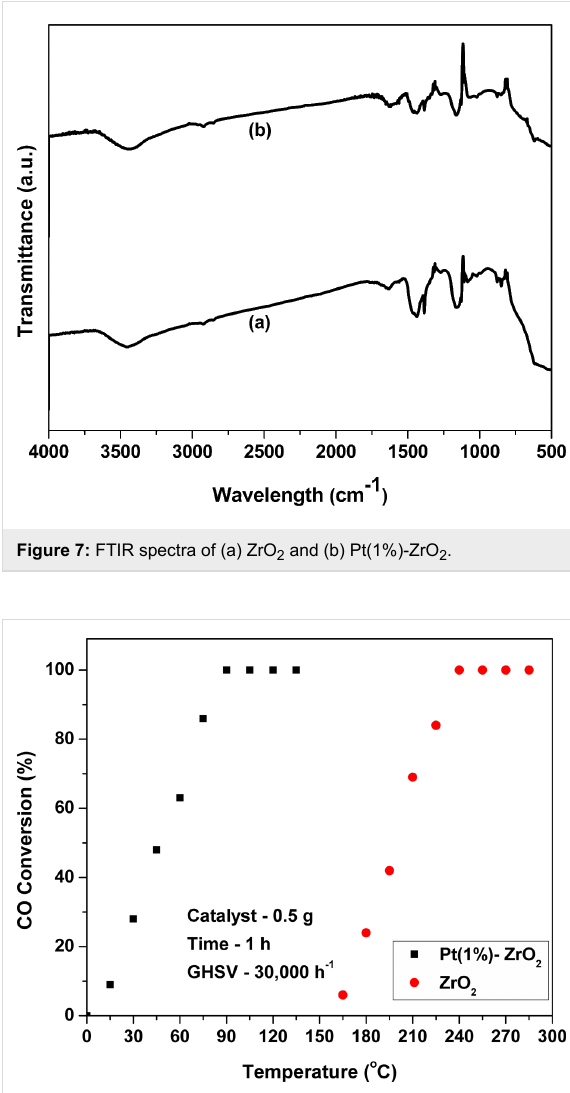
Figure 8: CO conversion as a function of the temperature for Pt(1%)- ZrO 2 and ZrO 2 (catalyst: 0.5 g, CO: 500 ppm, O 2 : 20% Ar balance, GHSV: 30,000 h − 1 ).